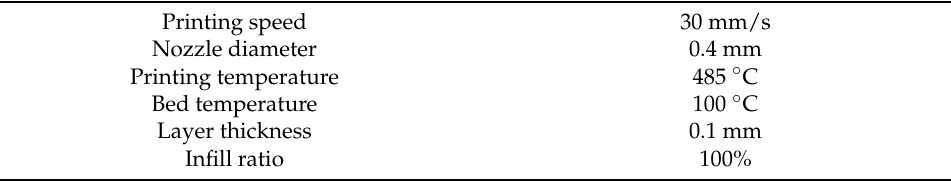
Table 1. FDM processing parameters provided by manufacturer.